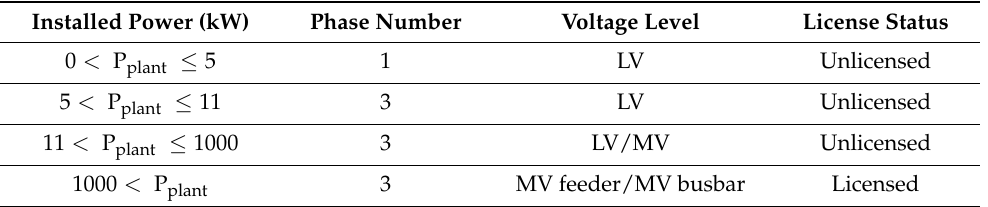
Table 6. Voltage levels of PV plants according to the installed power. Installed Power